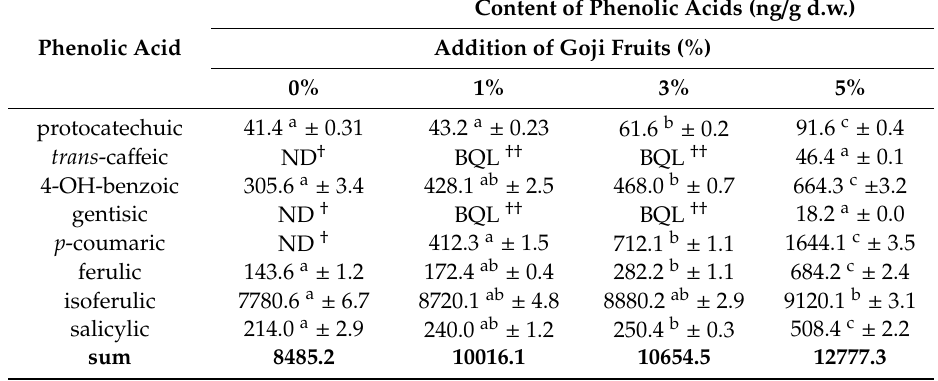
Content of Phenolic Acids (ng / g